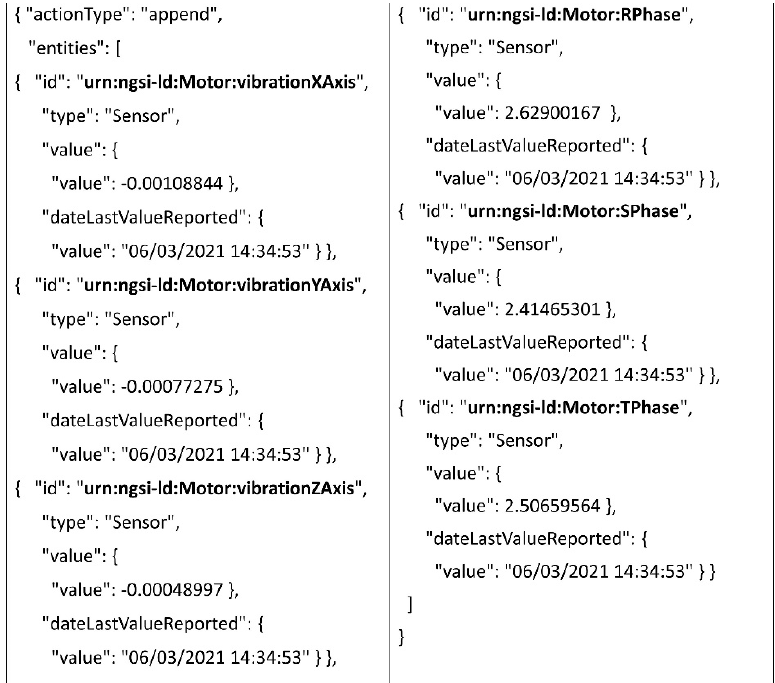
Figure 3. One of the representative Autonomous Transfer Vehicles utilized in the system verification use case involved an operational fault scenario with a road anomaly condition.